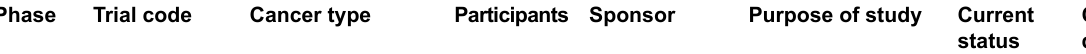
Table 2. Trials of dostarlimab ( continued )